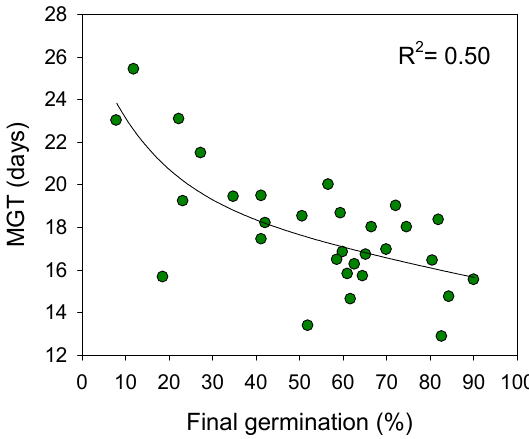
Figure 2. Relationship of final germination values vs. MGT values recorded at 8 °C.